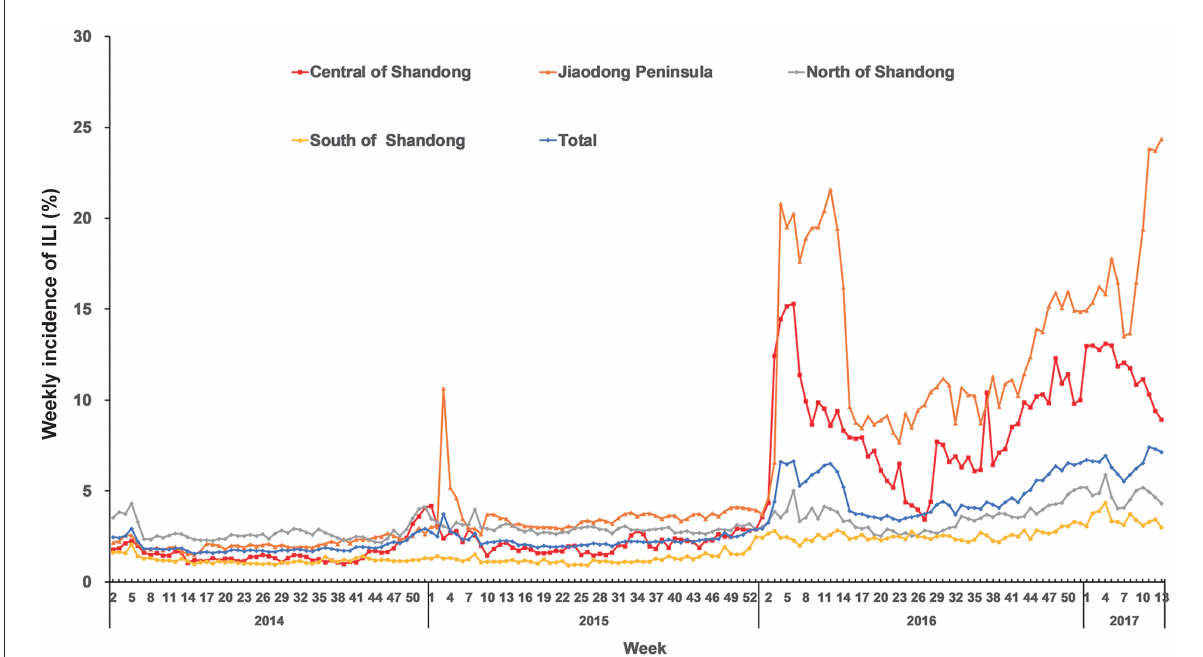
FIGURE1 Region-specific and total weekly incidences of ILI in Shandong Province from 2014 to